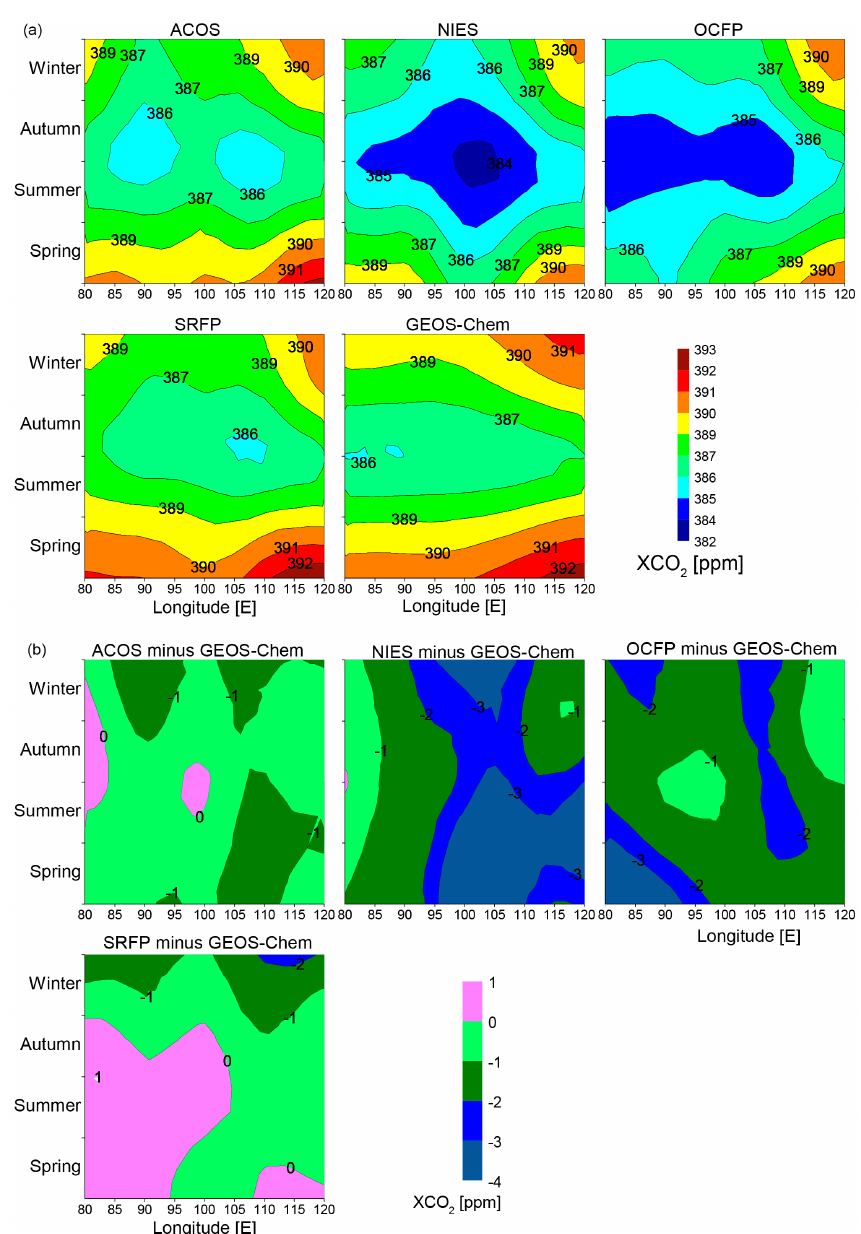
Figure 8. (a) The spatial (in the study latitude band) and temporal (in seasons) changing patterns of detrended XCO 2 from ACOS, NIES, OCFP, SRFP retrievals and GEOS-Chem simulations and (b) the differences of detrended XCO 2 to GEOS-Chem for ACOS, NIES, OCFP and